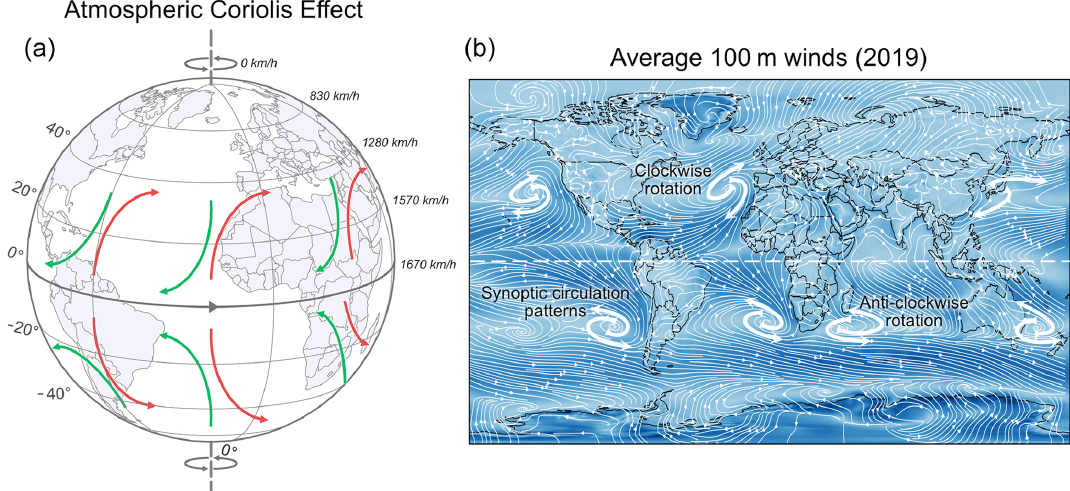
Figure 3. Illustration of the Coriolis effect on atmospheric circulation patterns. Panel (b) is produced using an average of the ERA5 100m winds for 2019 at 12:00UTC.